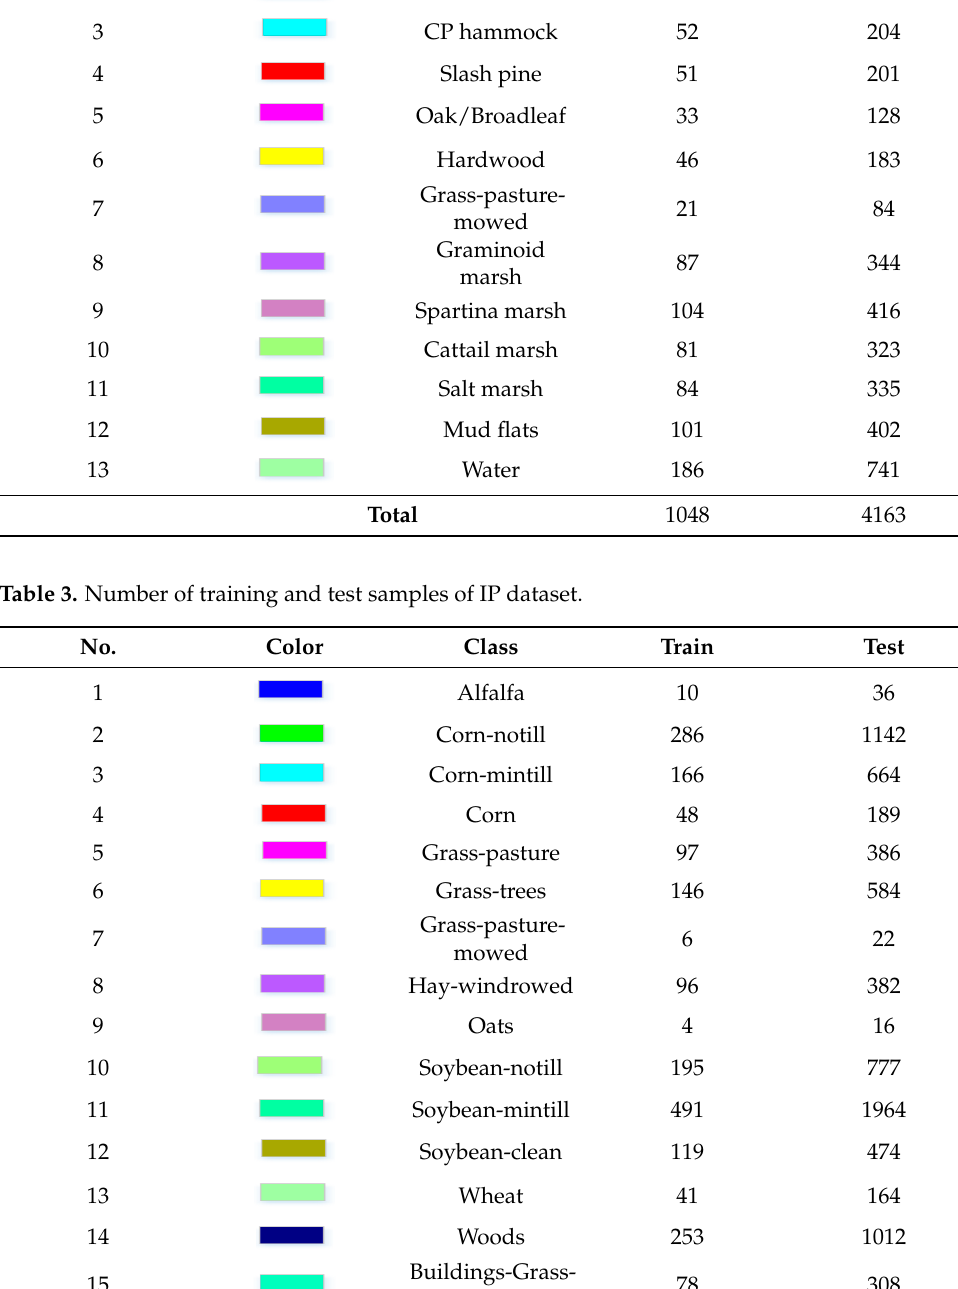
Table 2. Number of training and test samples of KSC dataset.